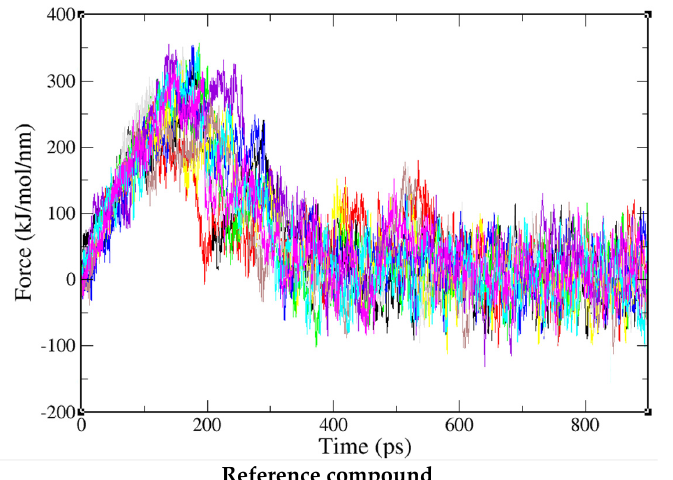
Figure 4. Force-time profiles of a representative SMD trajectory of compounds ( 1 and 2 ) and reference compound with PI3K/mTOR protein complex.